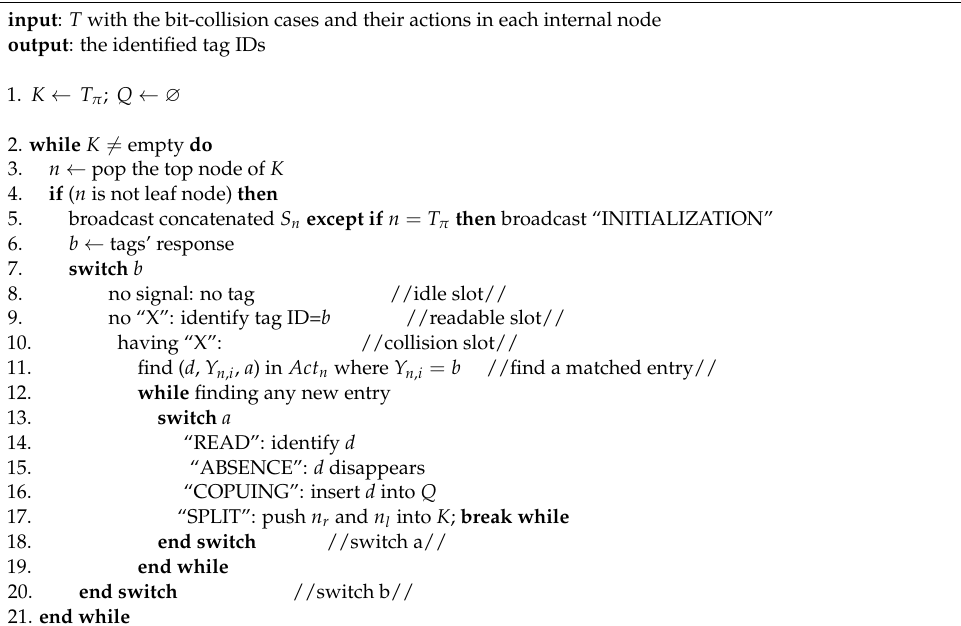
Algorithm 4. Pseudo-code for identification